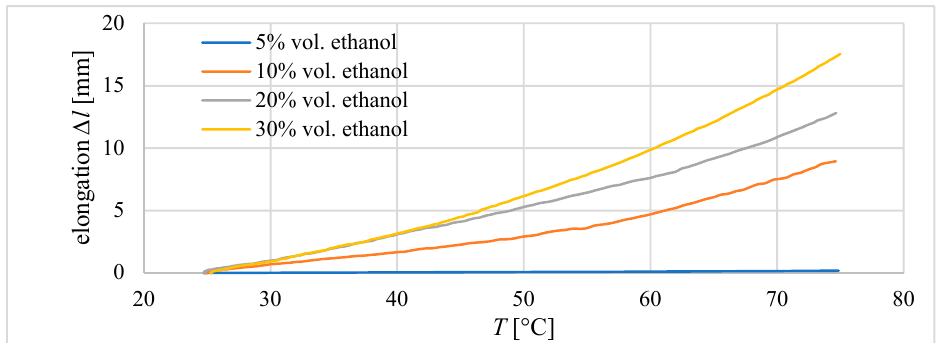
Figure 8. Elongation of the silicon–ethanol composite with different contents of ethanol during heat- ing. The dimensions of the composite core were diameter D = 20 mm and initial length l 0 = 40 mm. In the second experiment, during heating to 75 ◦ C, the movement of the composite was blocked and the blocking force was measured. The results are presented in Figure 9.